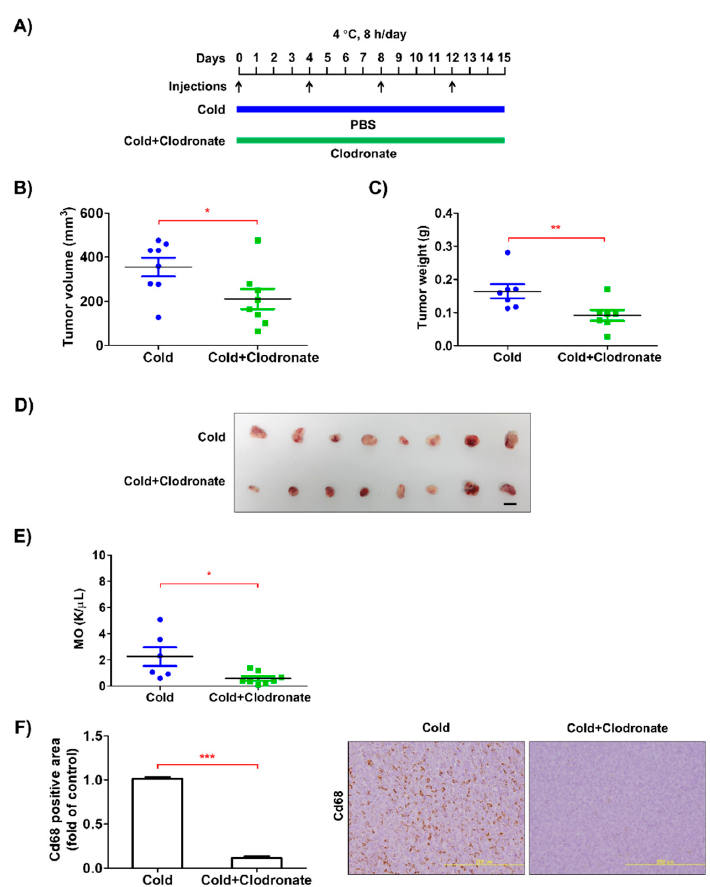
Figure 2. Macrophage depletion reduced low temperature-induced growth of allograft LLC cells. ( A ) LLC cells (1 × 10 5 cells/100 μ L PBS) were subcutaneously injected into the dorsum of mice. Clodronate liposomes were intraperitoneally injected into the mice at 7 mg/kg (first dose), followed by 3.5 mg/kg every 4 d for 15 d. PBS was injected as a control. ( B , C ) After 15 d, tumor volume and weight were measured. ( D ) Images of tumor samples from each group are presented. The bar indicates 1 cm. ( E ) Monocytes in peripheral blood were counted using a hematology analyzer. ( F ) The Cd68-positive area of tumor tissues was calculated by immunohistochemical analysis. Representative microscopic images (× 200) are shown. Data are expressed as the mean ± SD. * p < 0.05, ** p < 0.01 and *** p < 0.001 compared to the control group (PBS).